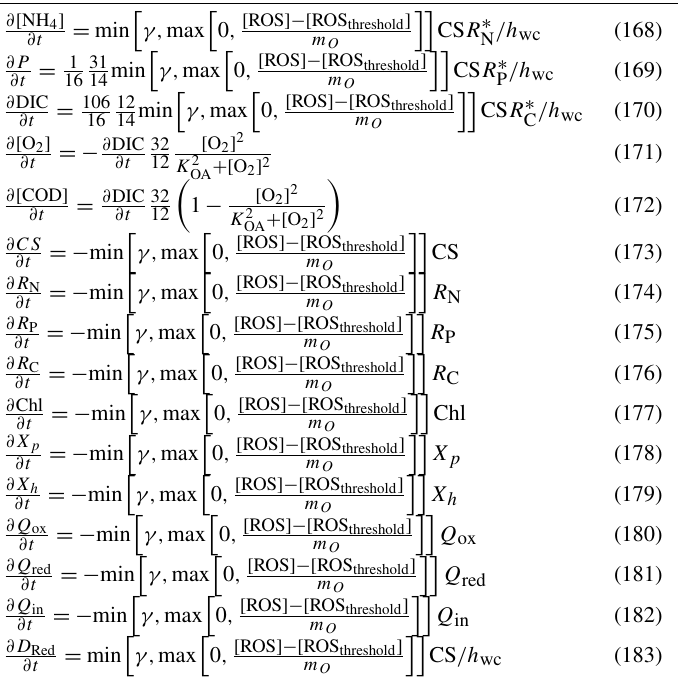
Table 29. Equations describing the expulsion of zooxanthellae and the resulting release of inorganic and organic molecules into the bottom water column